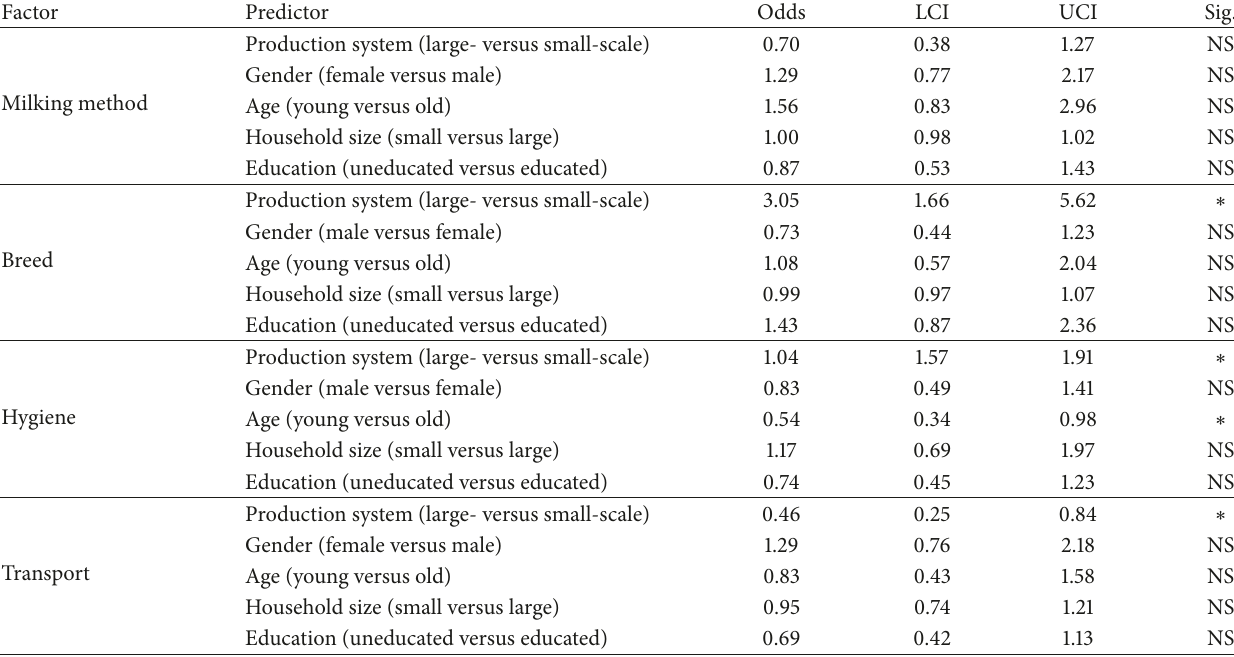
Table 2: Odds ratio estimate and lower (LCI) and upper confidence interval (UCI) of farmers indicating that different factors affect milk quality.